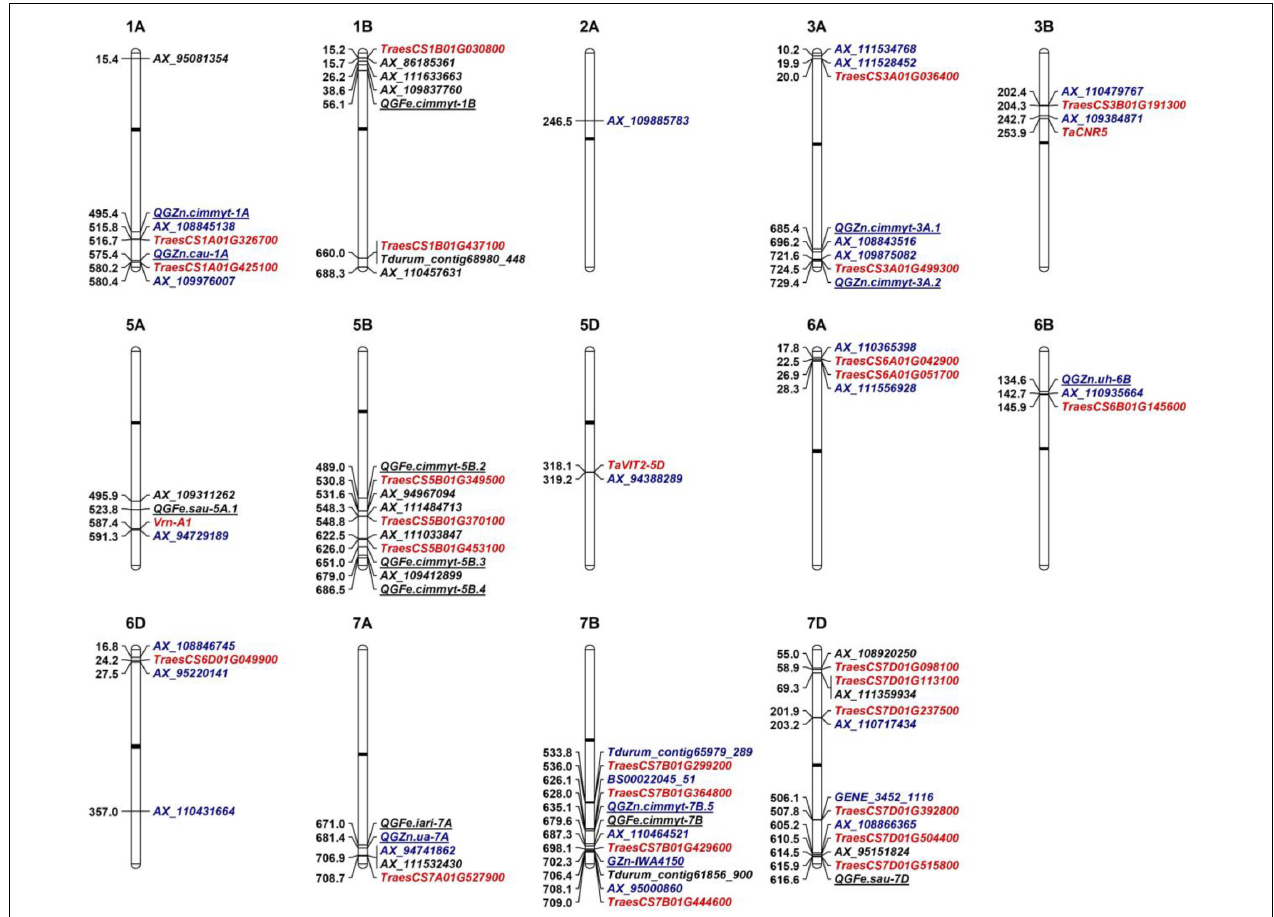
FIGURE 3 | Genetic architectures of grain zinc and iron in wheat. The top of each graph indicates the chromosome number in wheat and the left shows the physical positions based on IWGSC RefSeq v.1.0. The loci identified to associate with GZnC and GFeC are shown with black and blue fonts, respectively. The representative markers (noted in Table 2 ) identified in this study were used to be compared with previous reported QTL that are underlined. The closest linked markers or mid-points of previous reported QTL intervals were from Tong et al. (2020). Promising candidate genes are highlighted as red color. Black bars indicate the locations of